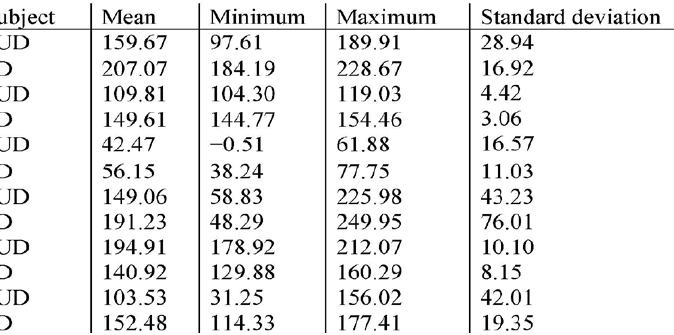
amplitude, minimum measurement, 1